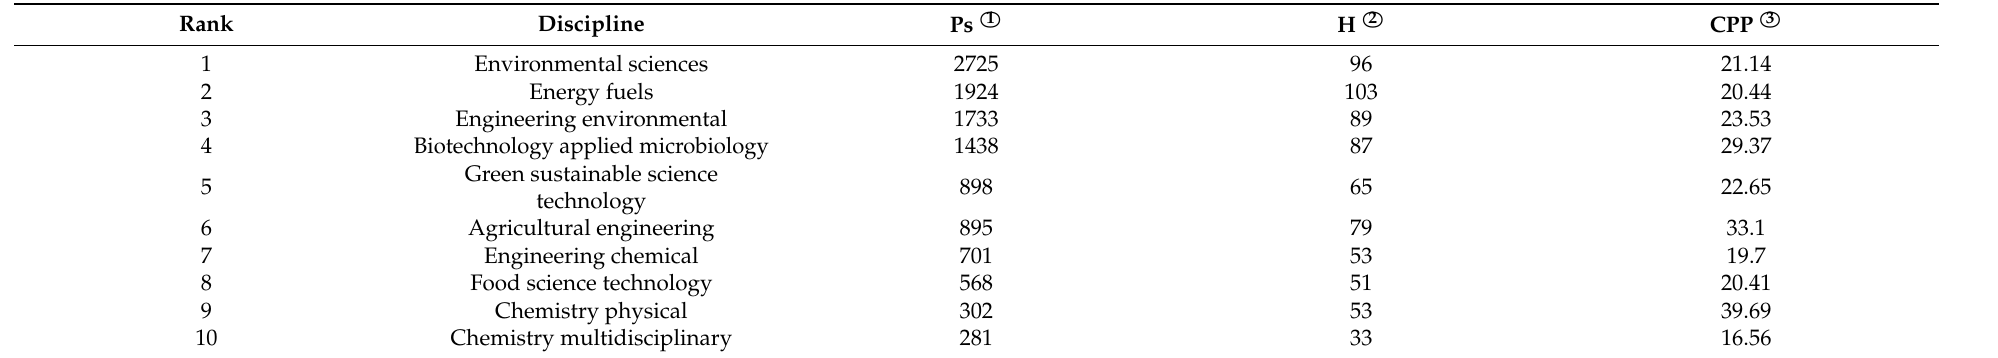
Table A4. Top 10 disciplines with most publications in FW